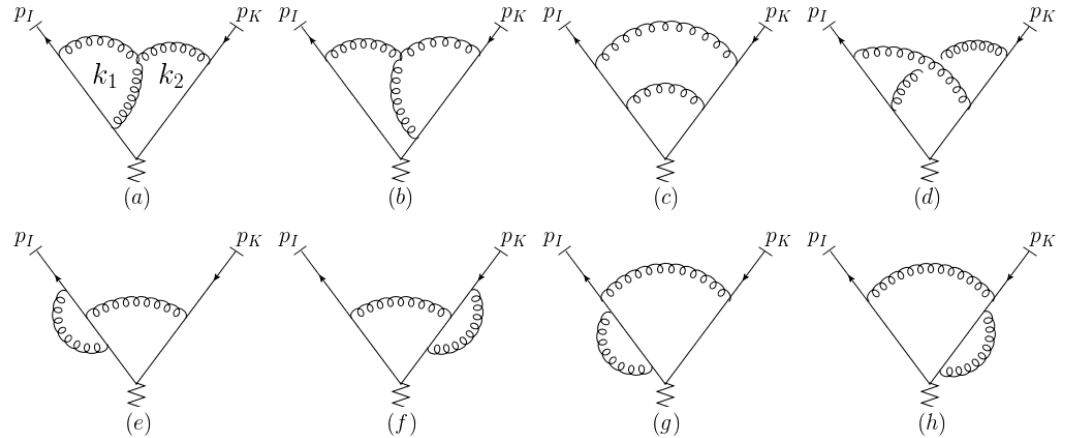
Figure 35. The two-loop QCD corrections to (cid:13) (cid:3) ; W (cid:6) ; Z ! q (cid:22) q